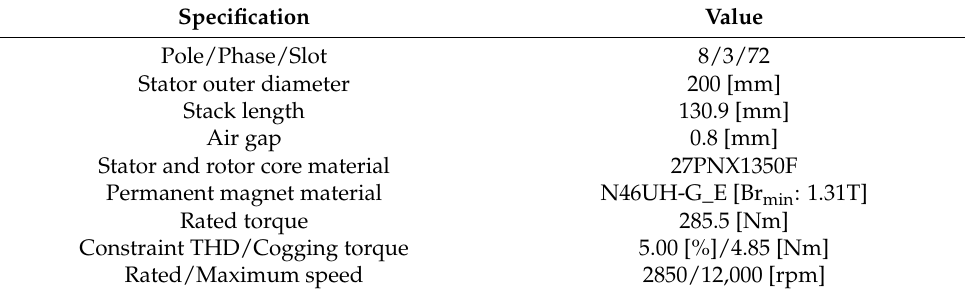
Table 2. The specifications of